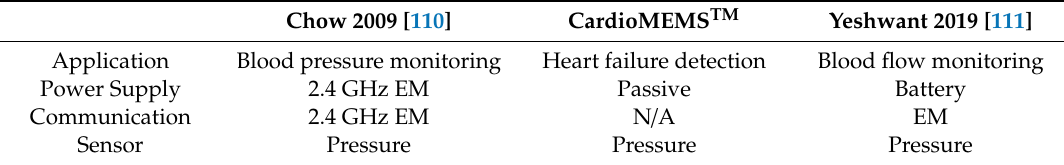
Table 6. Comparison of select cardiovascular wireless